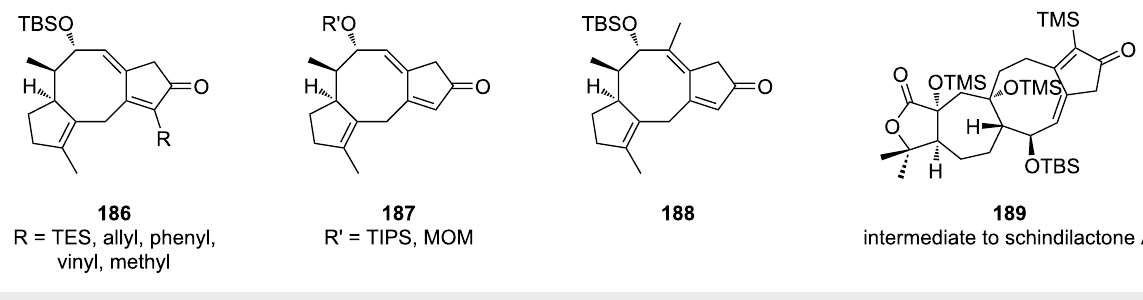
Figure 6: Scope of the Pauson–Khand reaction.